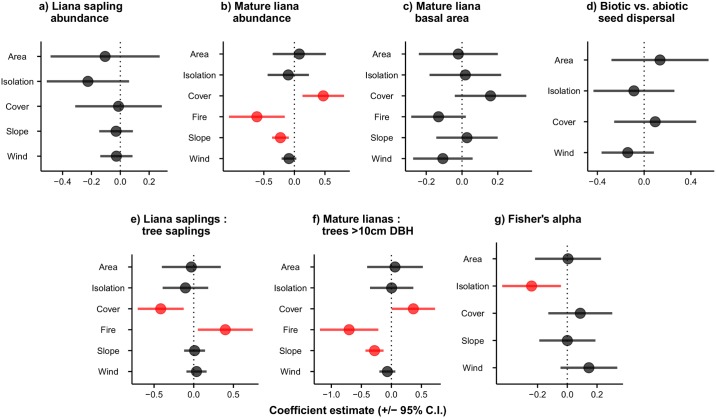
Standardised effect sizes of environmental variables associated with sapling and mature liana communities on forest islands.Coefficient estimates from maximal models are plotted with 95% confidence intervals. Points in red indicate that coefficient estimates and confidence intervals do not overlap zero.